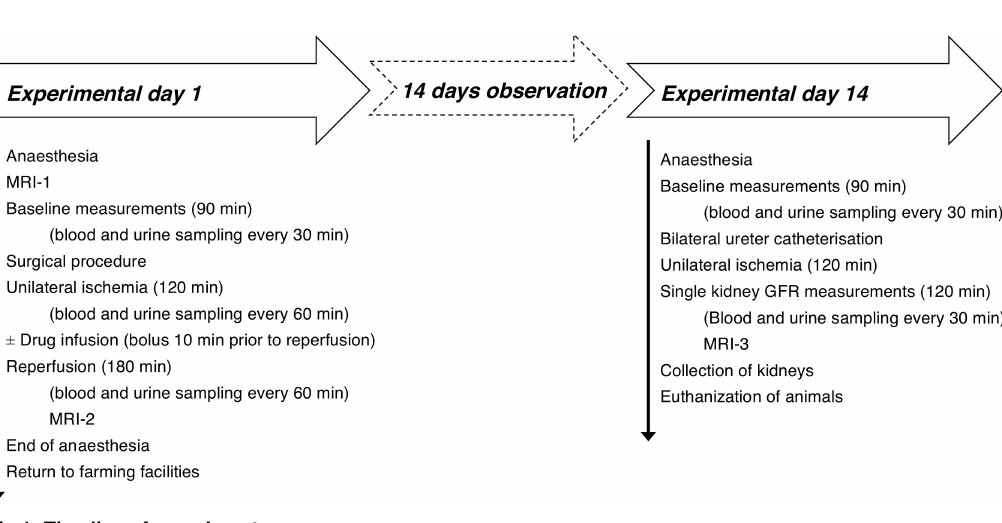
Fig 1. Timeline of